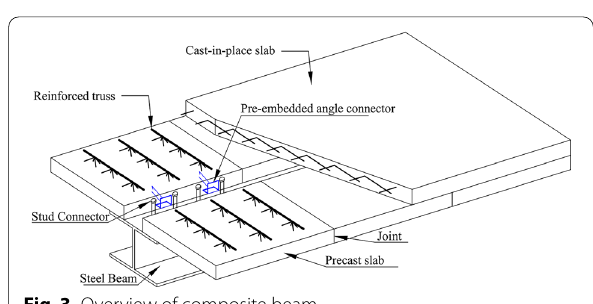
Fig. 3 Overview of composite beam.